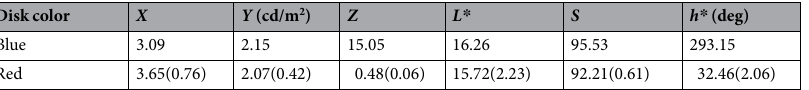
Table 1. Colorimetric values of the blue and the red disk color. Columns X , Y , and Z display the CIE XYZ tristimulus values according to the 10° CIE 1964 standard observer 49 , columns L * and h * display the lightness and hue values according to the CIE LCh 1976 system 50 , column S displays the saturation values calculated from the LCh 1976 chroma ( C * ) values: S = C * 2 /( C * 2 + L * 2 ) 1/2 · 100% 51 . L * , S , and h * are specified relative to a D65 white point. For the red stimulus, all values were averaged across the 13 remaining participants ( SD in